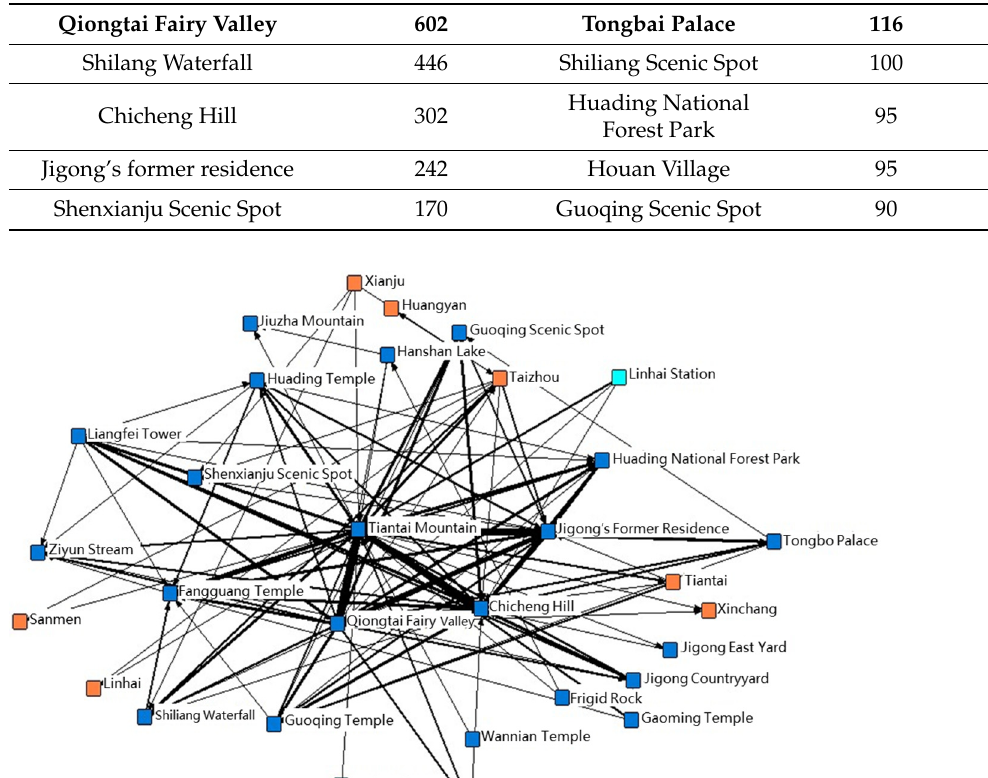
Table 3. Highly popular scenic spots in Tiantai (top 10).